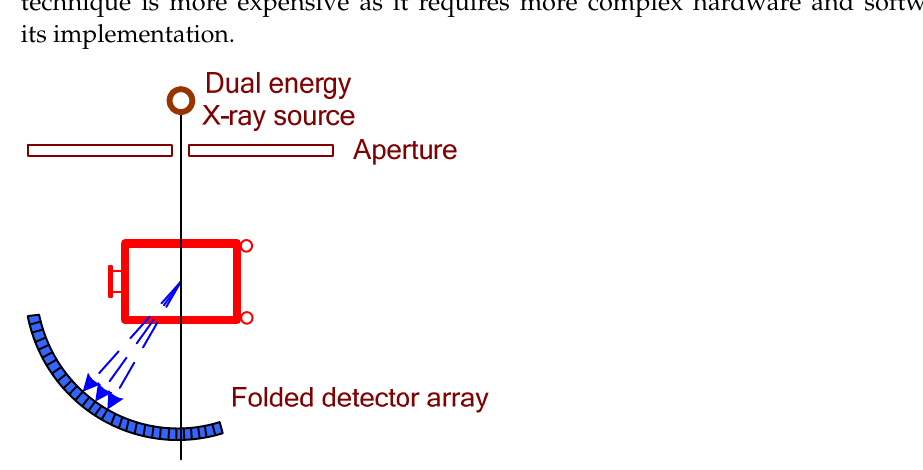
Figure 5. Schematic representation of a multiple energy X-ray computed tomography system.